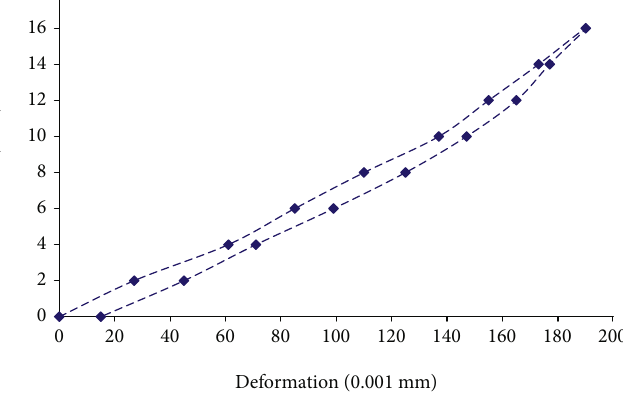
Figure 13: Curve of partial